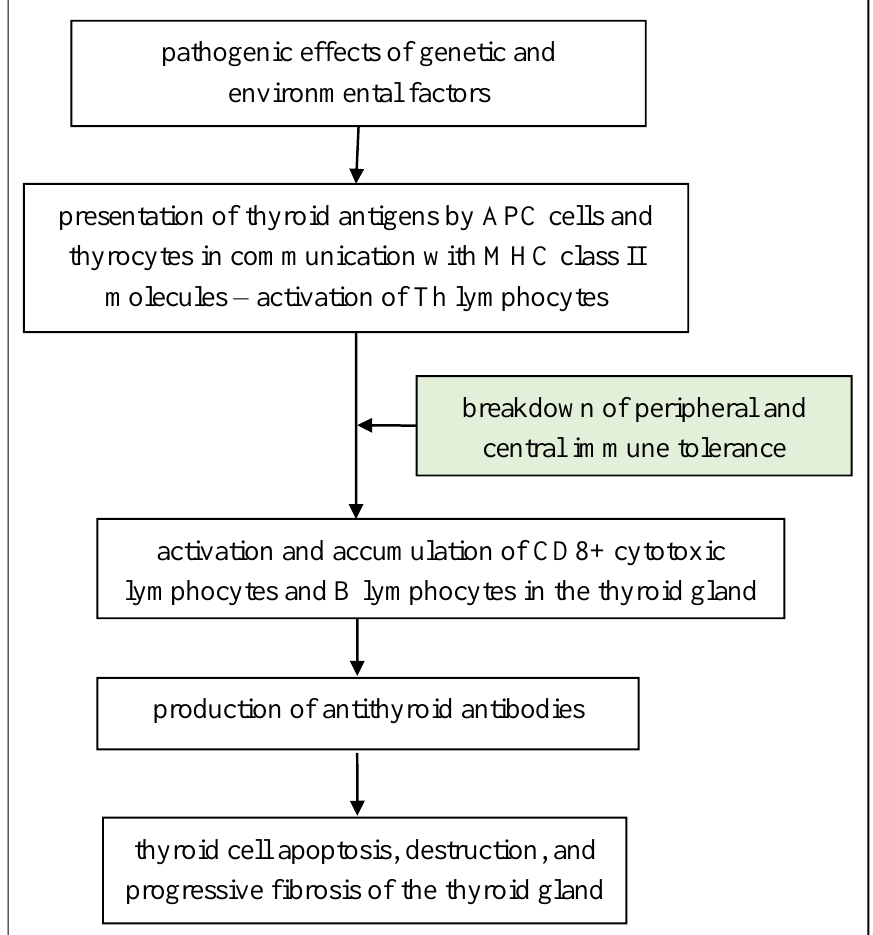
Figure 1. Diagram of the pathogenetic mechanism of Hashimoto’s thyroiditis, according to [4,38] — author’s own modification.